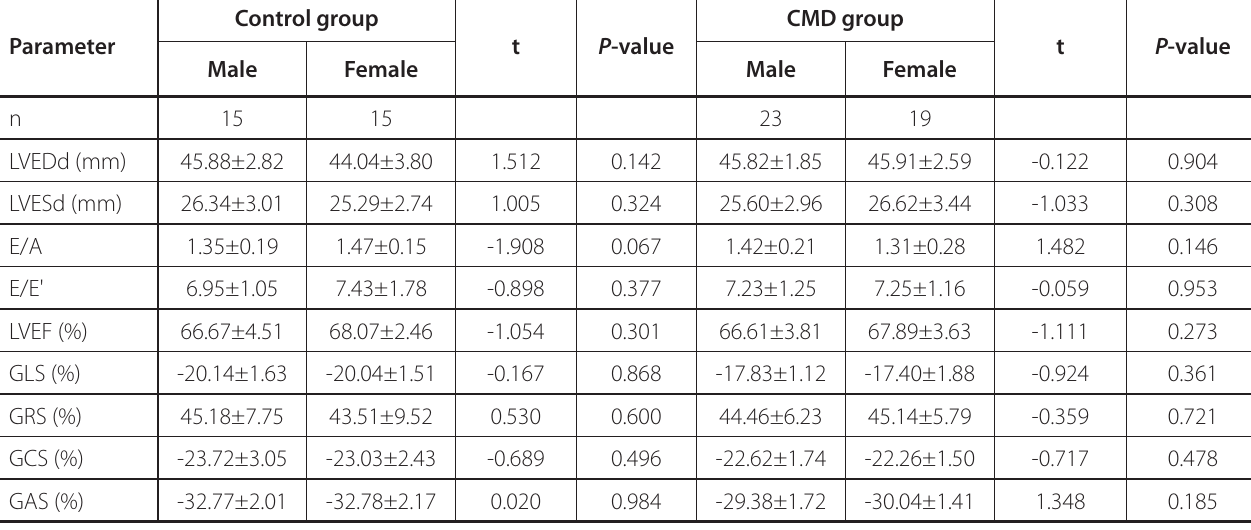
Table 4 . Comparison of conventional echocardiography parameters and left ventricular strain parameters between male and female subjects in the groups.